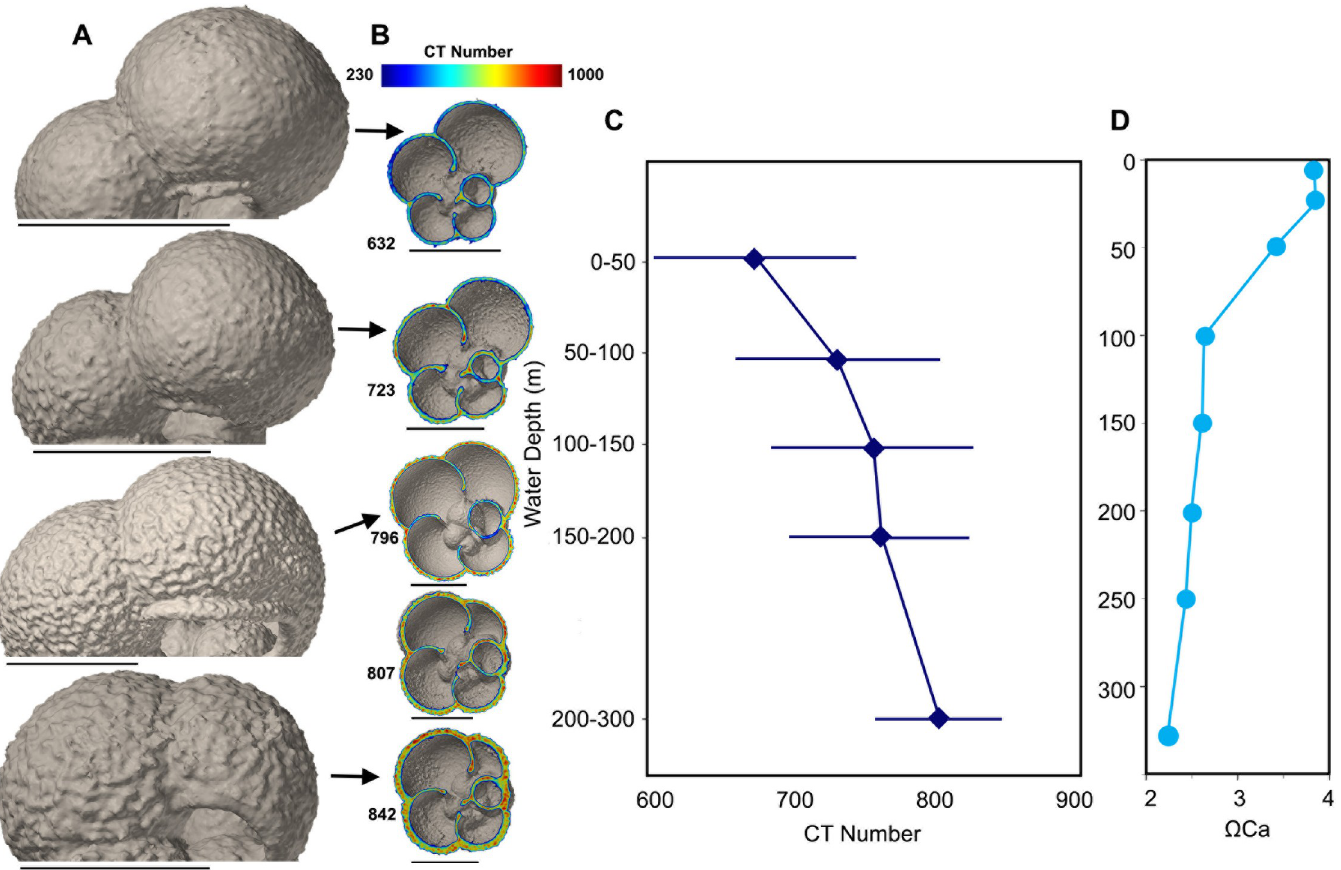
Fig 4. Neogloboquadrina pachyderma from water column. A) Texture of test surface of Neogloboquadrina pachyderma at four different depth intervals; 0–50 m, 50–100 m, 100–150 m and 200–300 m. B) Variation in inner and outer shell density of N . pachyderma with mean CT number of entire shell measured by XMCT. C) Mean CT number of N . pachyderma (n = 120), with error bars, plotted against water depth and calcite saturation. D) Calcite saturation at sampling site plotted against water depth. Scale bars measure 100 μ m.